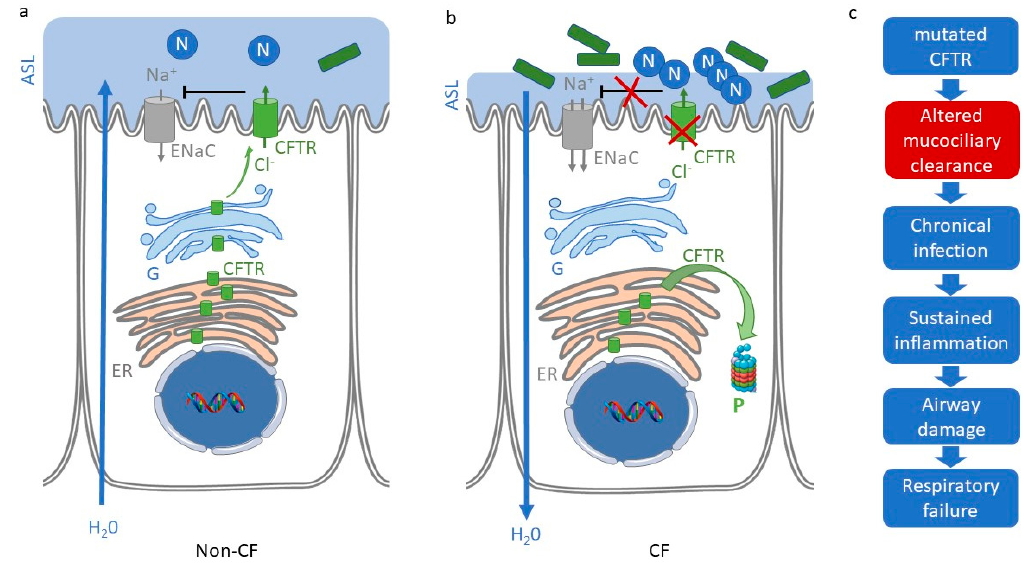
Figure 1. Cystic fibrosis (CF) and non-CF airway epithelial transport. ( a ) In non-CF airway epithelium, the airway surface liquid (ASL light blue) layer height is finely regulated by transepithelial chloride secretion and sodium absorption that involve the activities of the CFTR chloride channel (green arrow through CFTR) and the epithelial sodium channel (grey arrow through ENaC), respectively. In this tissue, the CFTR protein is normally expressed and trafficked (ER: endoplasmic reticulum, G: Golgi) toward the apical membrane of epithelial cells to play a role as a chloride channel and to down regulate ENaC activity. ( b ) In the case of the most common CF mutation, the CFTR protein is retained in the ER and degraded by the proteasome (P). This results in altered chloride secretion trough CFTR and regulation of ENaC (red cross) and leads to an ASL height decrease that favors bacterial (green rectangle) and neutrophil (N) accumulation in the airway. ( c ) Classical hypothesis for CF airway pathogenesis showing the central role of dehydration/ altered mucociliary clearance (red) that results from ion transport abnormality.